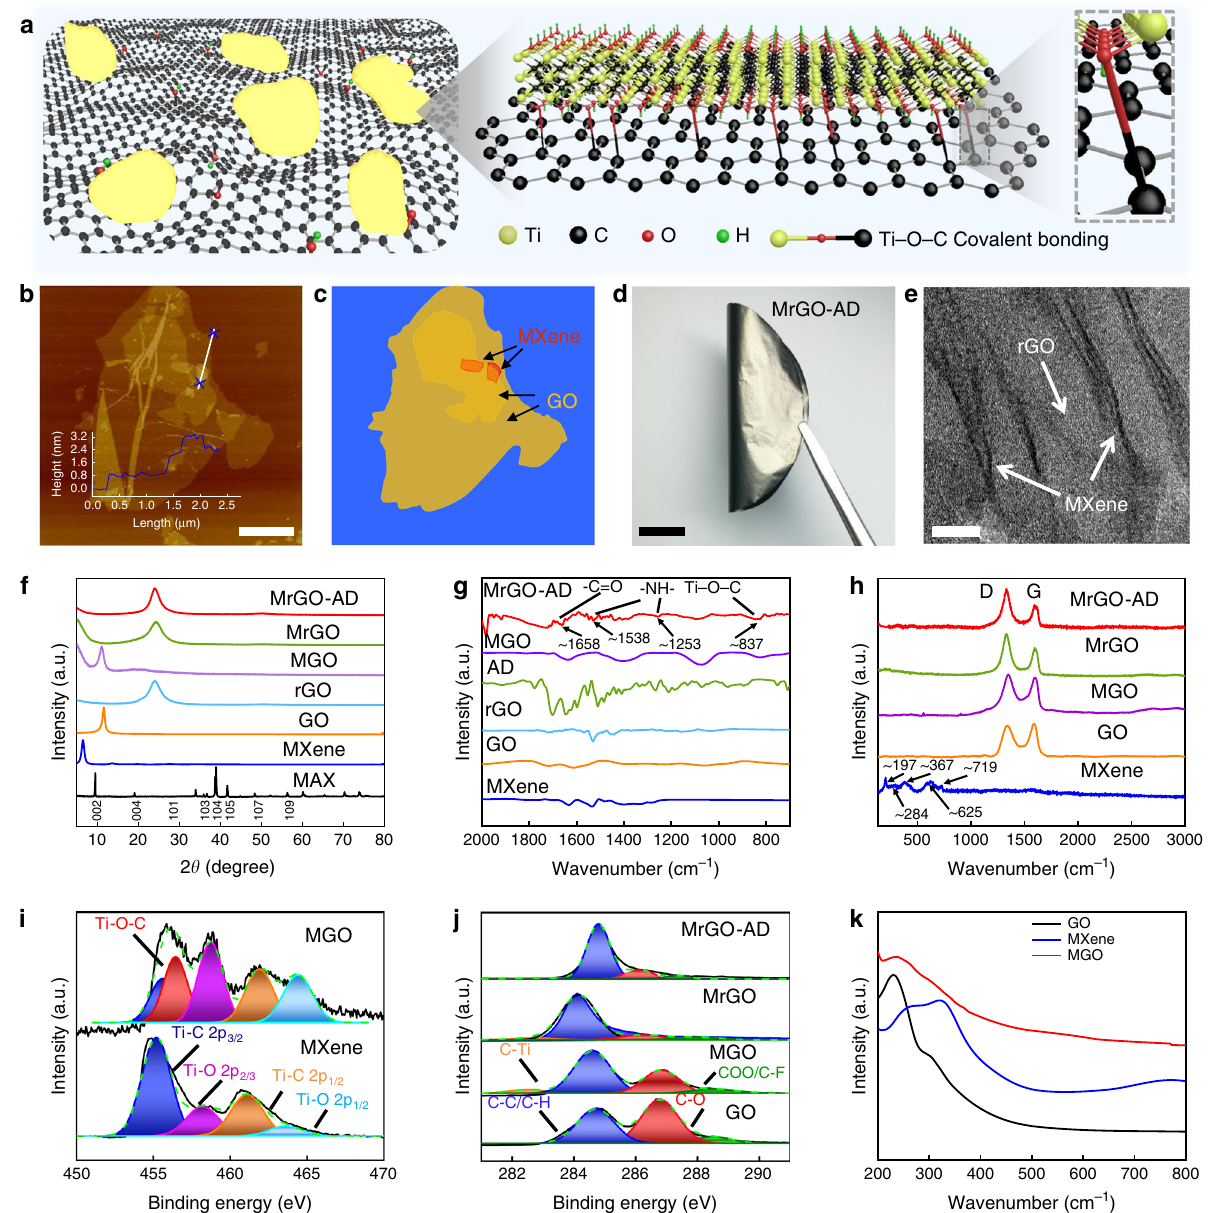
Fig. 1 Physical characterization and interactions. a Schematic model of MXene-GO platelets showing the formation of Ti – O-C covalent bonding. b Atomic force microscope (AFM) of MXene nanosheet-functionalized GO platelets. Scale bar, 5 μ m. c An illustration of the Mxene-functionalized GO platelets of b. d , A photograph of a folded MrGO-AD sheet. Scale bar, 1 cm. e A high-resolution transmission electron microscopy (HR-TEM) image of the cross-section of the MrGO-AD sheet. Scale bar, 10 nm. f X-ray diffraction (XRD) patterns. g Comparisons of Fourier-transform infrared spectroscopy (FTIR) spectra and h Raman spectroscopy spectra of obtained sheets. i Ti 2p spectra of MXene and MGO sheets. A new peak at a binding energy of 456.5 eV indicates the formation of Ti – O – C covalent bonding between MXene and GO nanosheets. j Comparison of C 1s spectra. k UV-vis absorption spectra of MXene, GO, and MGO